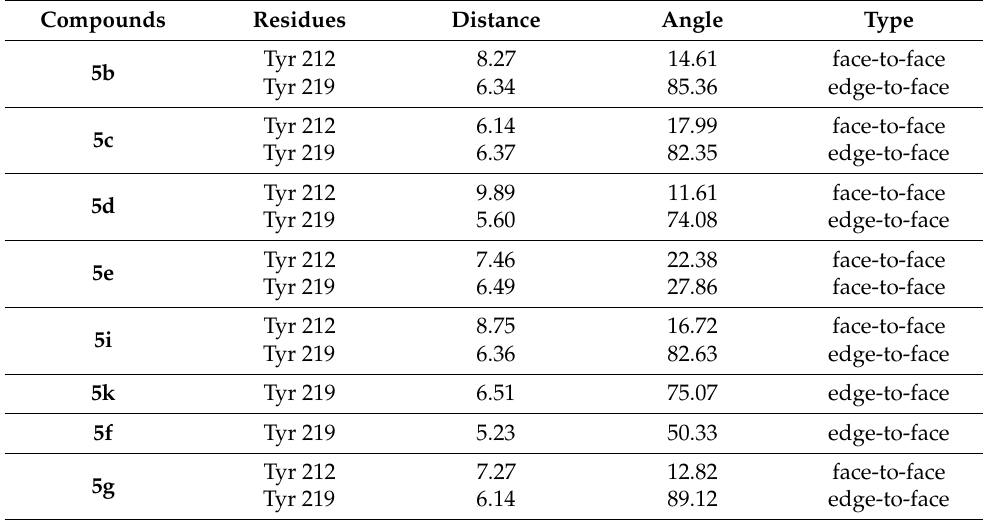
Table 3. Aromatic interactions ( π - π ) between AURKA and the top-scored compounds. Compounds Residues Distance Angle Type